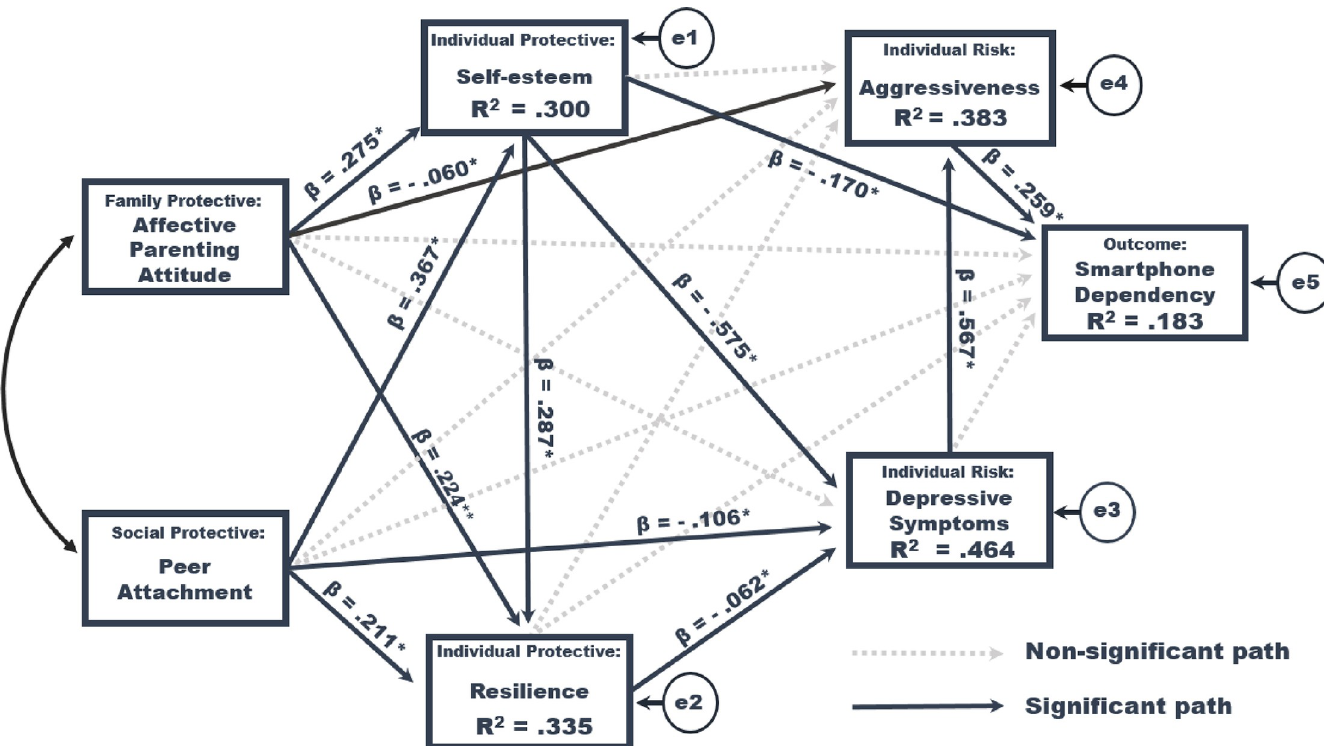
Fig 2. A path diagram of the study. Model fit statistics: χ 2 = 0.00, df = 0. Solid lines represent significant standardized path coefficients ( � p < .05, �� p < .001). Error variances appear in small circles.